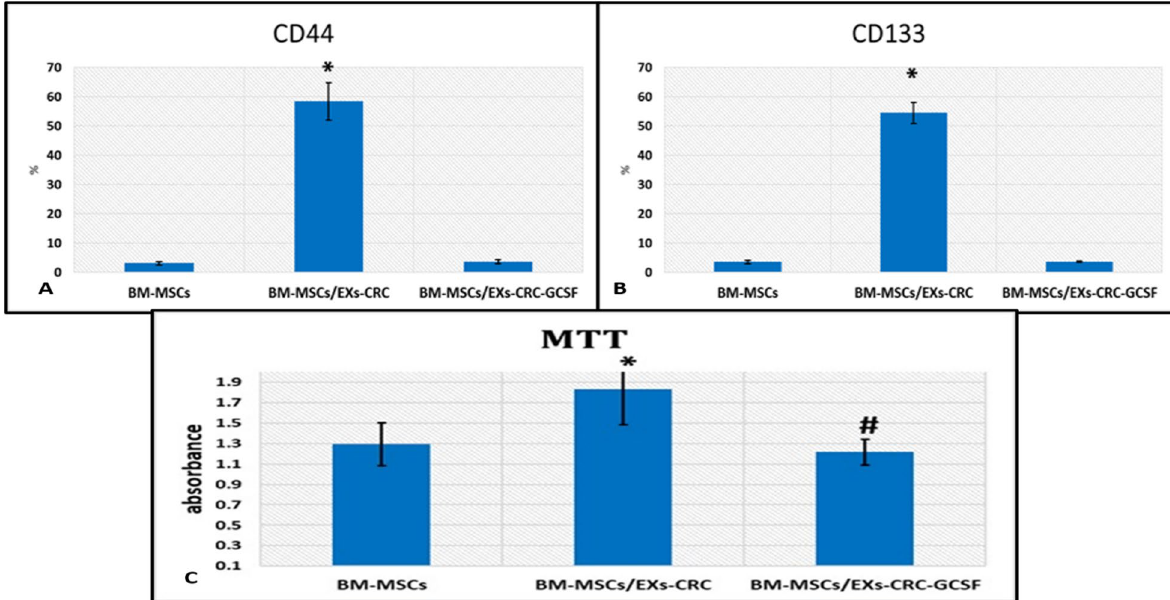
Fig. 3 A and B comparison of FACS analysis for CSC marker CD44&CD133 between BM-MSCs studied groups. C comparison of MTT between BM-MSCs studied groups. * Denotes significant difference compared to BM-MSCs group. # Denotes significant difference compared to BM-MSCs/ EXs-CRC